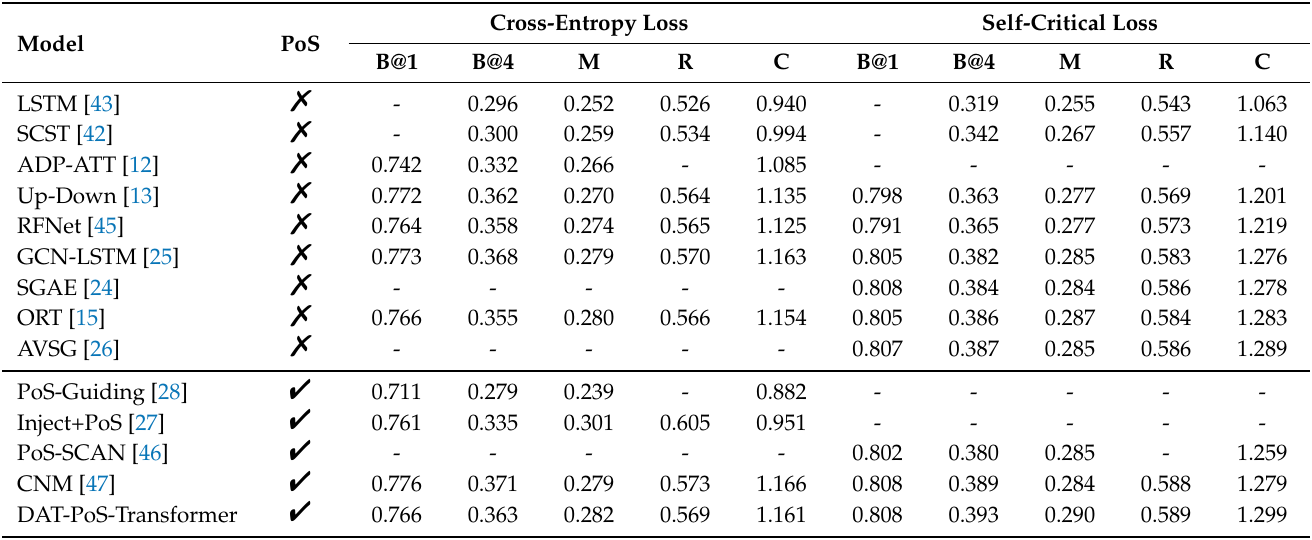
Table 5. Comparison of image captioning performance with state-of-the-art methods on MSCOCO “Karpathy” test split.